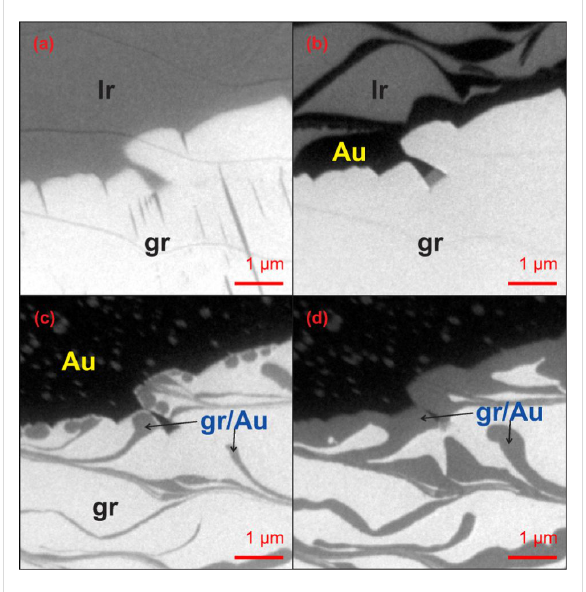
Figure 8: LEEM images at a start voltage of 12 eV illustrating the evolution of the graphene/Ir(100) interface upon deposition of Au. A large graphene crystal (gr) is visible in all images (lower half), brighter than the Ir surrounding it (upper half). (a) Initial configuration of the sample at T = 520 °C. (b) The same area after a dose of 0.25 ML Au at sample temperature of 600 °C. Au (dark areas) has decorated steps and step bunches. (c) The same area after a dose of 0.85 ML of Au. At this stage, Au has entirely covered the initially bare Ir surface and the intercalation under graphene has just started (darker areas). Note also that small graphene islands have nucleated on the Au/Ir surface. (d) The same area after a dose of 0.9 ML of